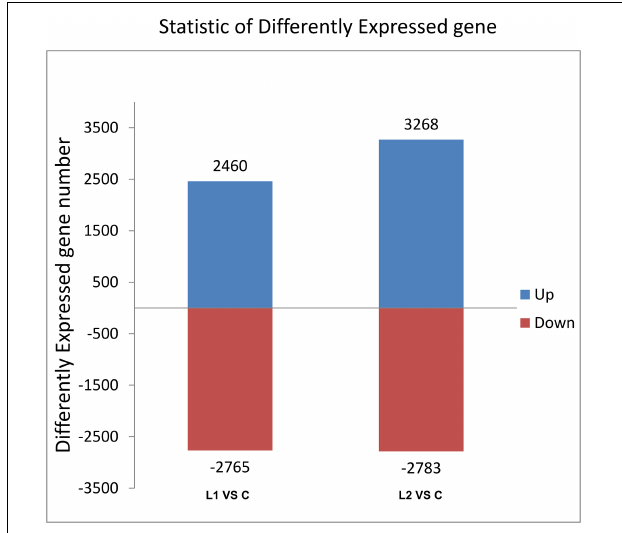
FIGURE 4 | Histogram of differentially expressed gene statistics. The horizontal axis is each comparison group; the vertical axis is the number of differentially expressed genes in the comparison groups, where up is the number of significant genes with upregulated expression and down is the number of significant genes with downregulated expression.